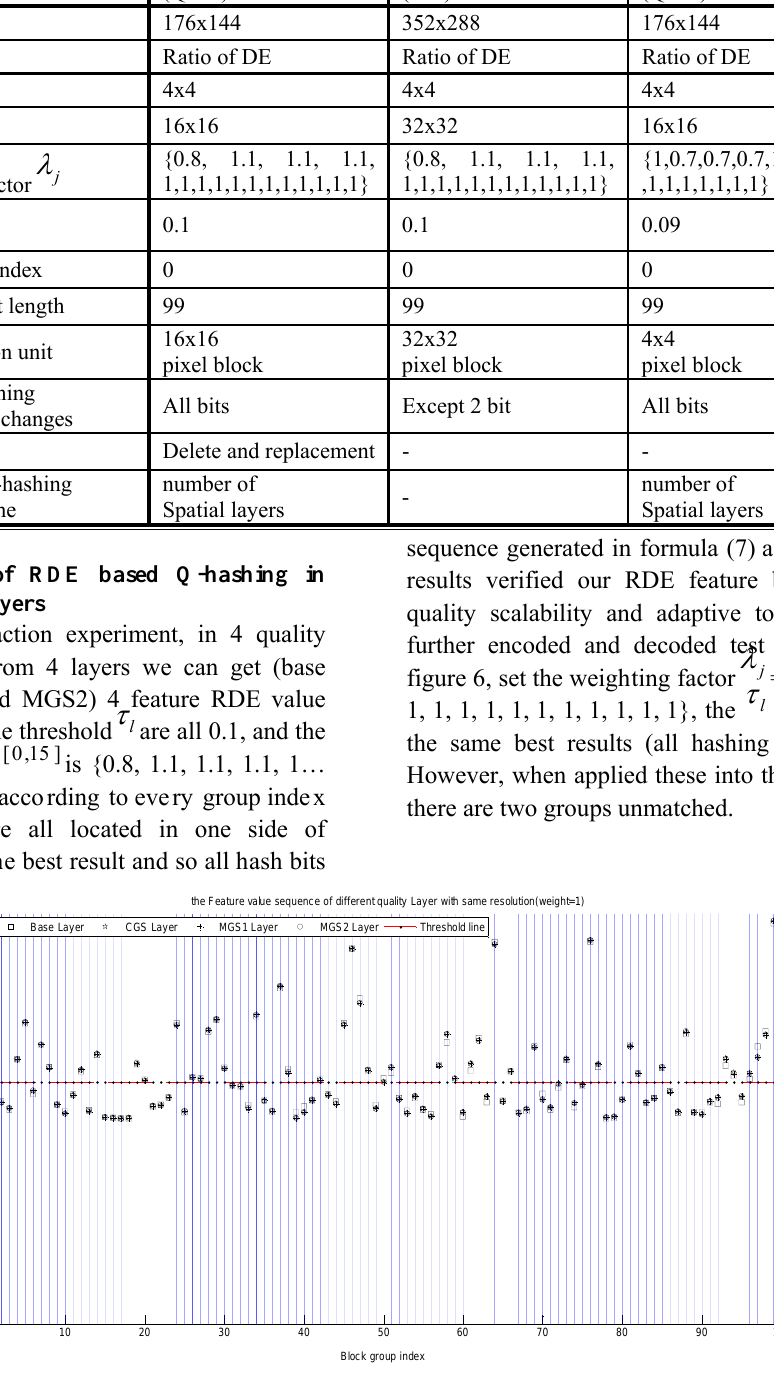
Figure 6. The invariance of RDE between different quality frames (Base, CGS, MGS1, and